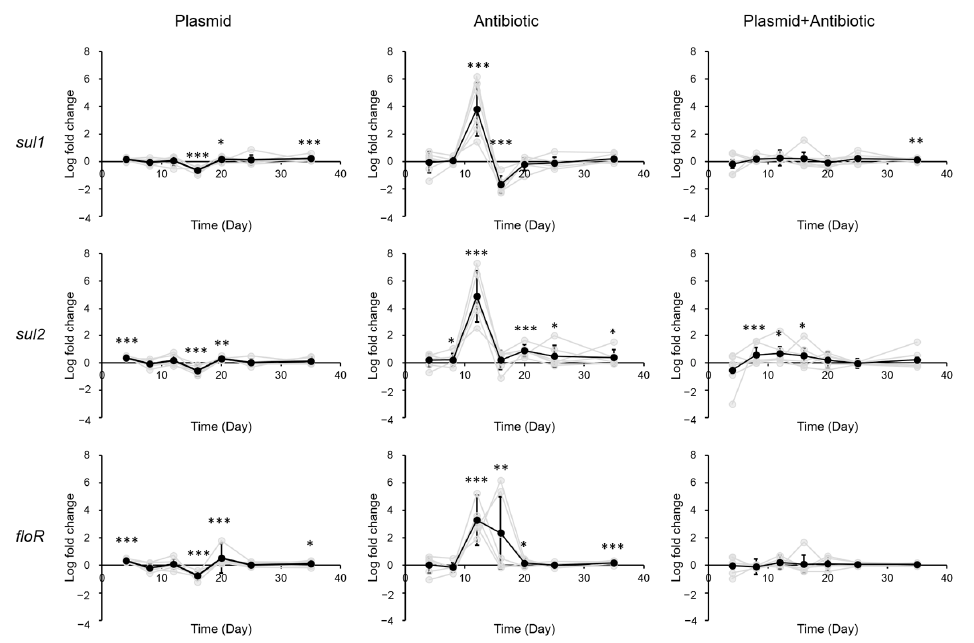
Figure 2. Change of ARG levels in mouse stomach after exposure to pR55 (plasmid), sulfadiazine (antibiotic), or pR55 + sulfadiazine (plasmid + antibiotic). Each gray line indicates a mouse group (male groups 1–3, female groups 1–3). Black line indicates average of all six groups. Error bars indicate standard deviation of 6 replicates (3 males and 3 females). *, p < 0.05; **, p < 0.01; ***, p < 0.001. In the small intestine, exposure to eARGs also led to only minimal changes in ARG levels. In comparison to the stomach, a smaller (1–3 log, average 1.95 log) yet still signifi-